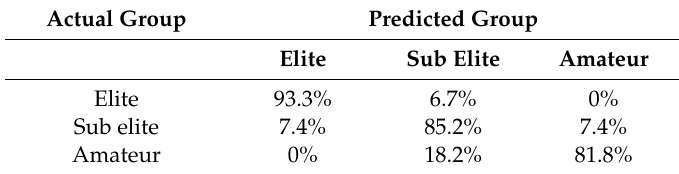
Table 4. Classification matrix for the players’ actual and predicted playing. Actual Group Predicted Group